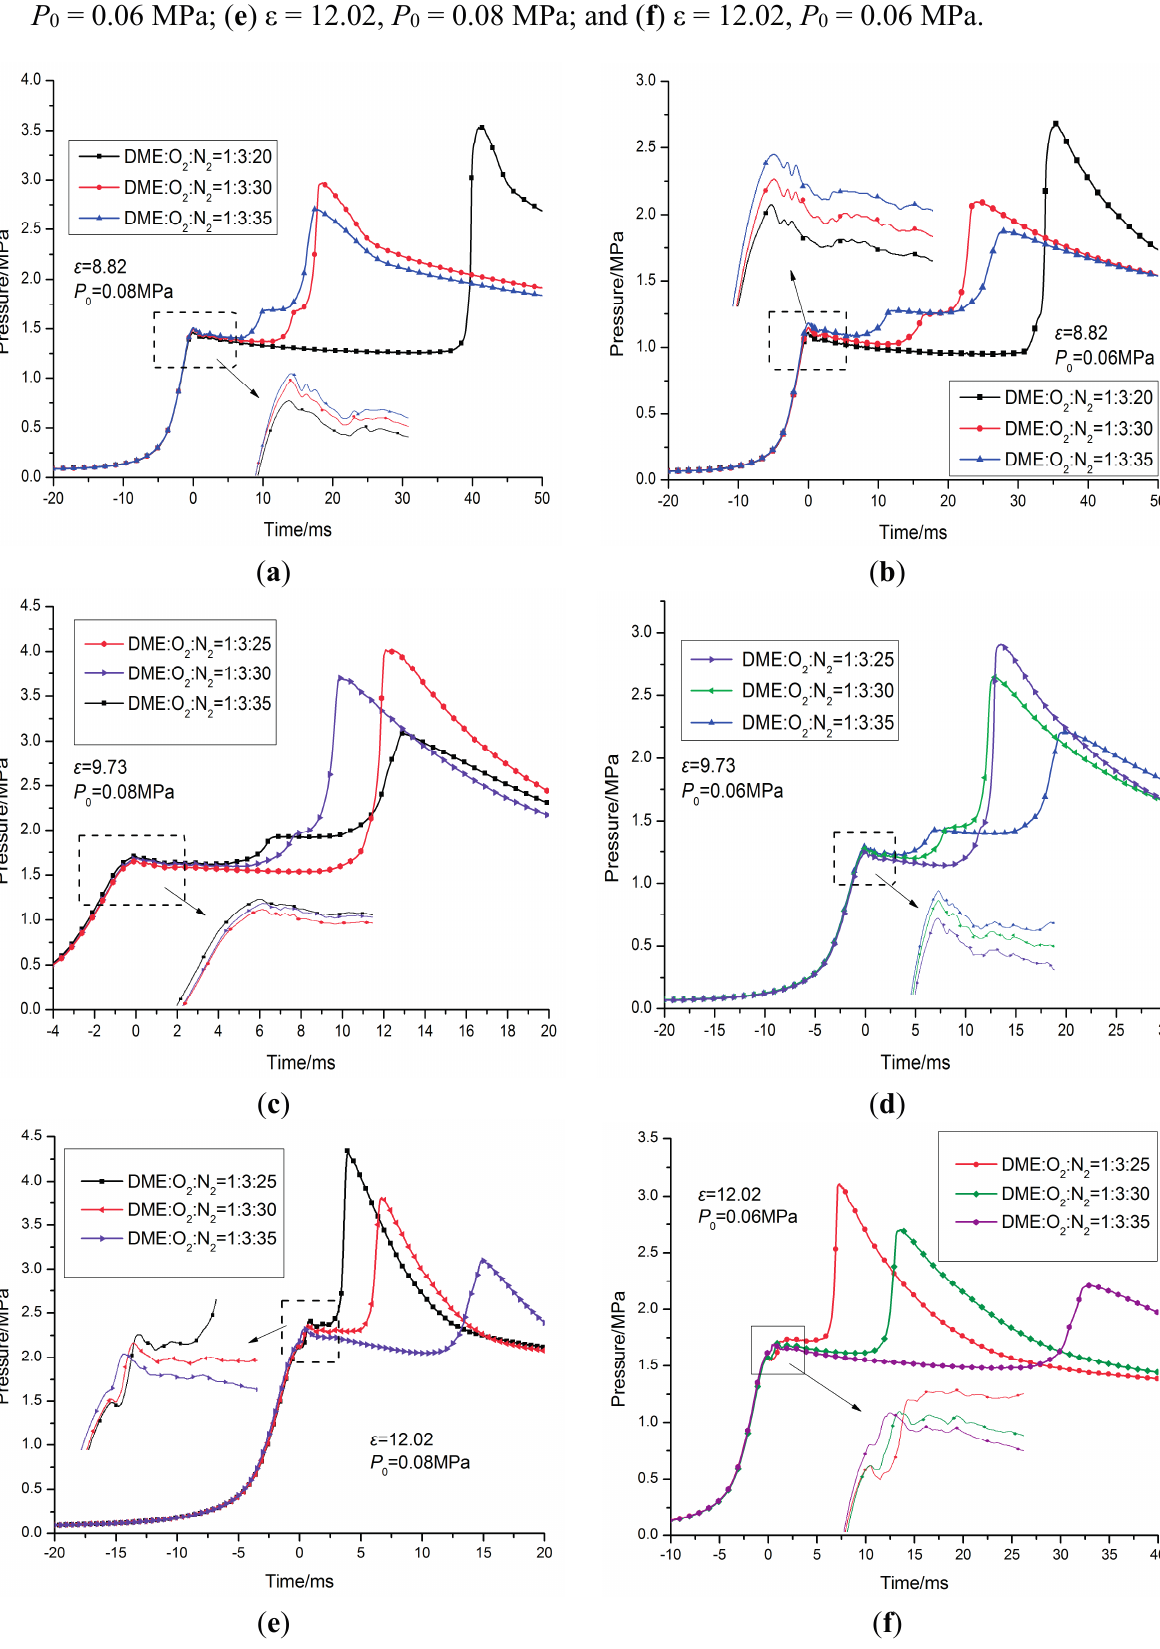
Figure 19. Effect of nitrogen dilution ratio on two-stage ignition delay: ( a ) ε = 8.82, P 0 = 0.08 MPa; ( b ) ε = 8.82, P 0 = 0.06 MPa; ( c ) ε = 9.73, P 0 = 0.08 MPa; ( d ) ε =